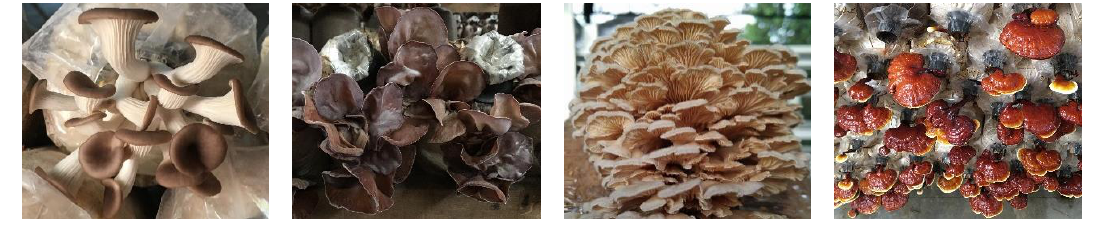
Figure 1. Mushroom species used in the study. From left: P. ostreatus , A. polytricha , S. commune and G. lucidum .